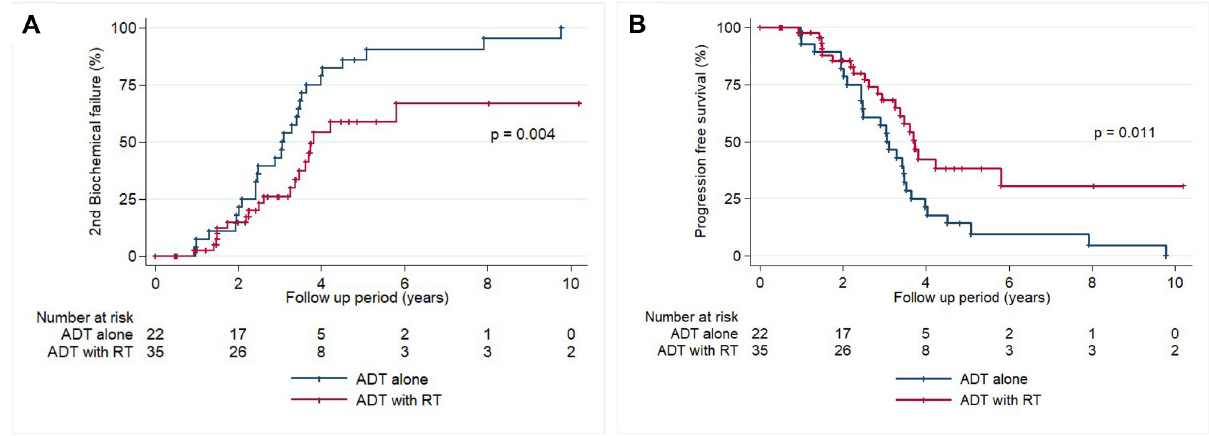
Fig 3. Actuarial curves for the subgroup patients with positive LN � 2 or PSA nadir after RP � 0.005 ng/ml. (A) Actuarial curves for 2 nd biochemical failure according to salvage treatment method. (B) Actuarial curves for progression-free survival according to salvage treatment method. Abbreviations: ADT, androgen deprivation therapy; LN, lymph node; PSA, prostate-specific antigen; RP, radical prostatectomy; RT,